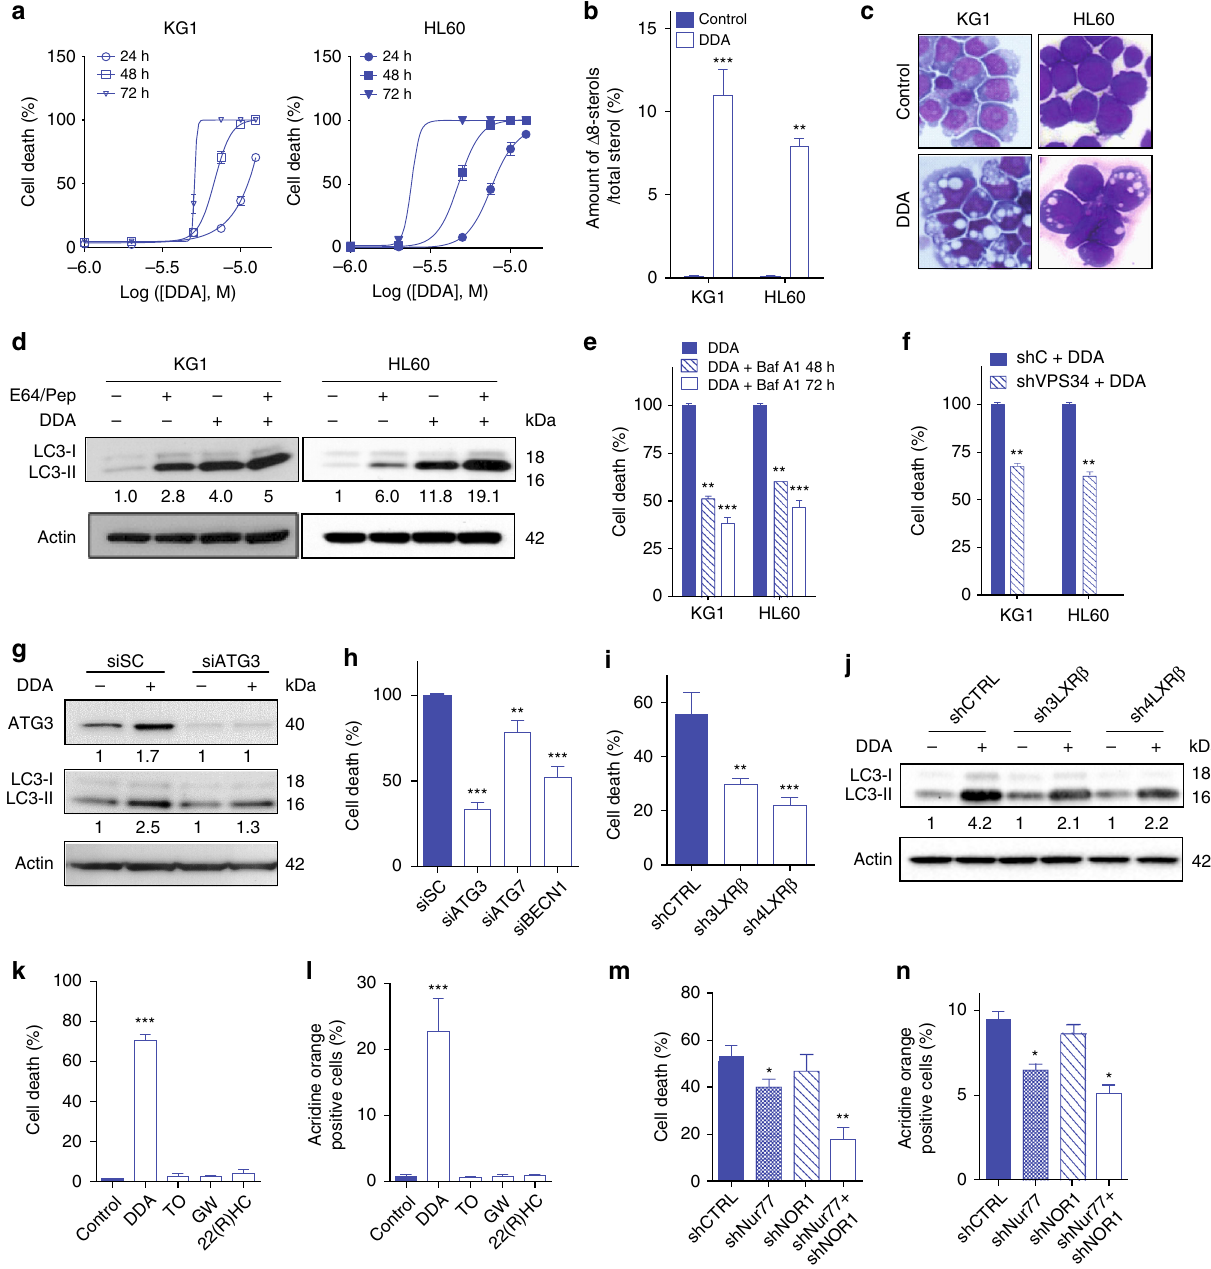
Fig. 6 DDA induces lethal autophagy in AML cells via LXR β . a DDA-induced cell death in KG1 and HL60 cells was determined over time as in Fig. 1b. b Quanti fi cation of the Δ 8-sterols that had accumulated in KG1 and HL60 cells treated without or with 2.5 µ M DDA. c May – Grünwald – Giemsa staining of KG1 and HL60 cells treated or not with DDA. d Immunoblots of LC3 proteins in cells treated or not with 2.5 µ M DDA, and E64 + pepstatin A (Pep). e Effect of the pharmacological inhibitor of autophagy Baf A1 on DDA cytotoxicity at 48 and 72 h. f DDA cytotoxicity in KG1 or HL60 cells permanently transfected with control shRNA (shC) or shRNA against VPS34 (shVPS34) after 72 h treatment. g Immunoblots of ATG3 and LC3 proteins in KG1 cells transfected with control scramble siRNA (siSC) or siRNA against ATG3 (siATG3). Seventy-two hours after transfection, cells were treated for 24 h with 5 µ M DDA. h Analysis of DDA cytotoxicity in KG1 cells transfected with control scramble siRNA (siSC), siATG3, siATG7, or siBECN1. Seventy-two hours after transfection, cells were treated for 24 h with 5 µ M DDA. i Analysis of DDA cytotoxicity in KG1 cells transfected with shCTRL, sh3LXR β , or sh4LXR β . Cells were treated for 24 h with 5 µ M DDA or vehicle. j Immunoblots of LC3 protein expression in cells transfected with shCTRL, sh3LXR β , or sh4LXR β and treated with 5 µ M DDA or vehicle for 24 h. Analysis of the cytotoxicity k and acridine orange-positive vesicles l in KG1 cells treated or not with 5 µ M DDA, 2 µ M TO, 2 µ M GW, or 10 µ M 22(R)HC. The presence of Nur77 and NOR1 is required in DDA cytotoxicity ( m ) and autophagy ( n ). Data from a , b , e , f , h , i , k , l , m , n are the means ± S.E.M. of three experiments performed in triplicate, * P < 0.05, ** P < 0.01, *** P < 0.001 t -test. All images and densitometry values are representative of three independent